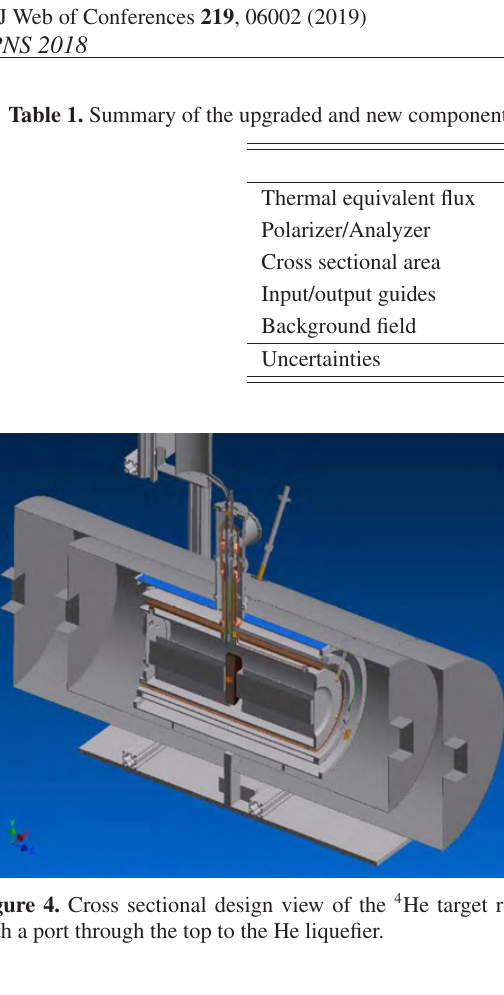
Figure 5. Projections of g 2 as a function of λ c from the proposed A measurement at NG-C (dashed-red) compared with constraints from LANSCE measurement (longdashed-blue) [46], K- 3 He comagnetometry (a) [47] and from a neutron measurement using Ramsey spectroscopy (b)